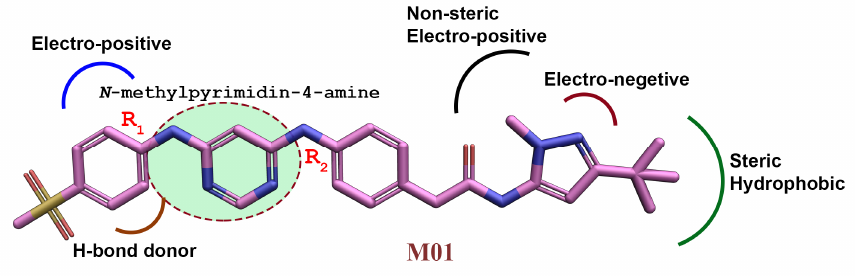
Figure 9. The three-dimensional structure–activity relationship by taking compound M01 as a ref-